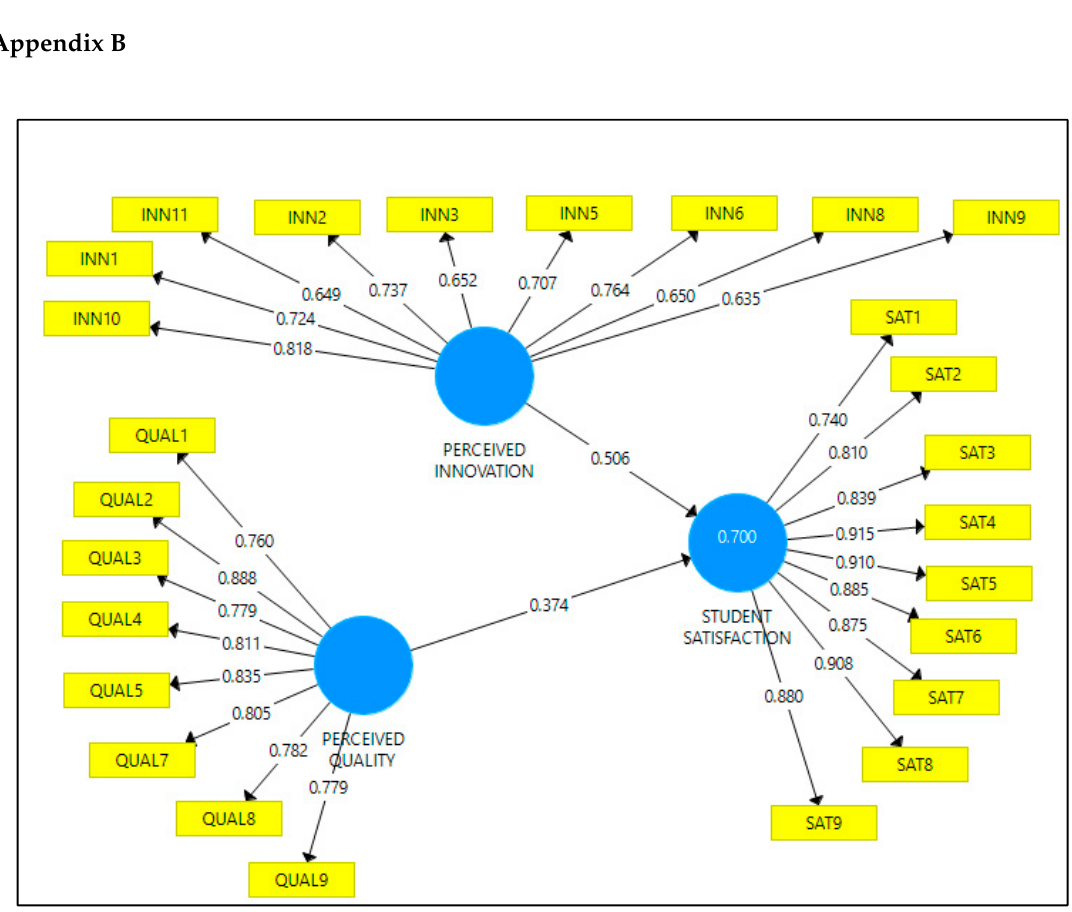
Figure A1. Explanatory nomogram.